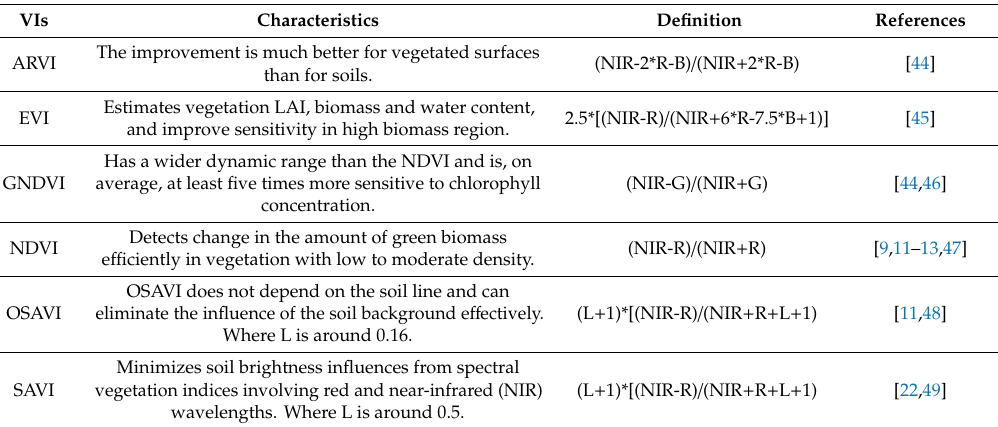
Table 3. Di ff erent VI for the research.